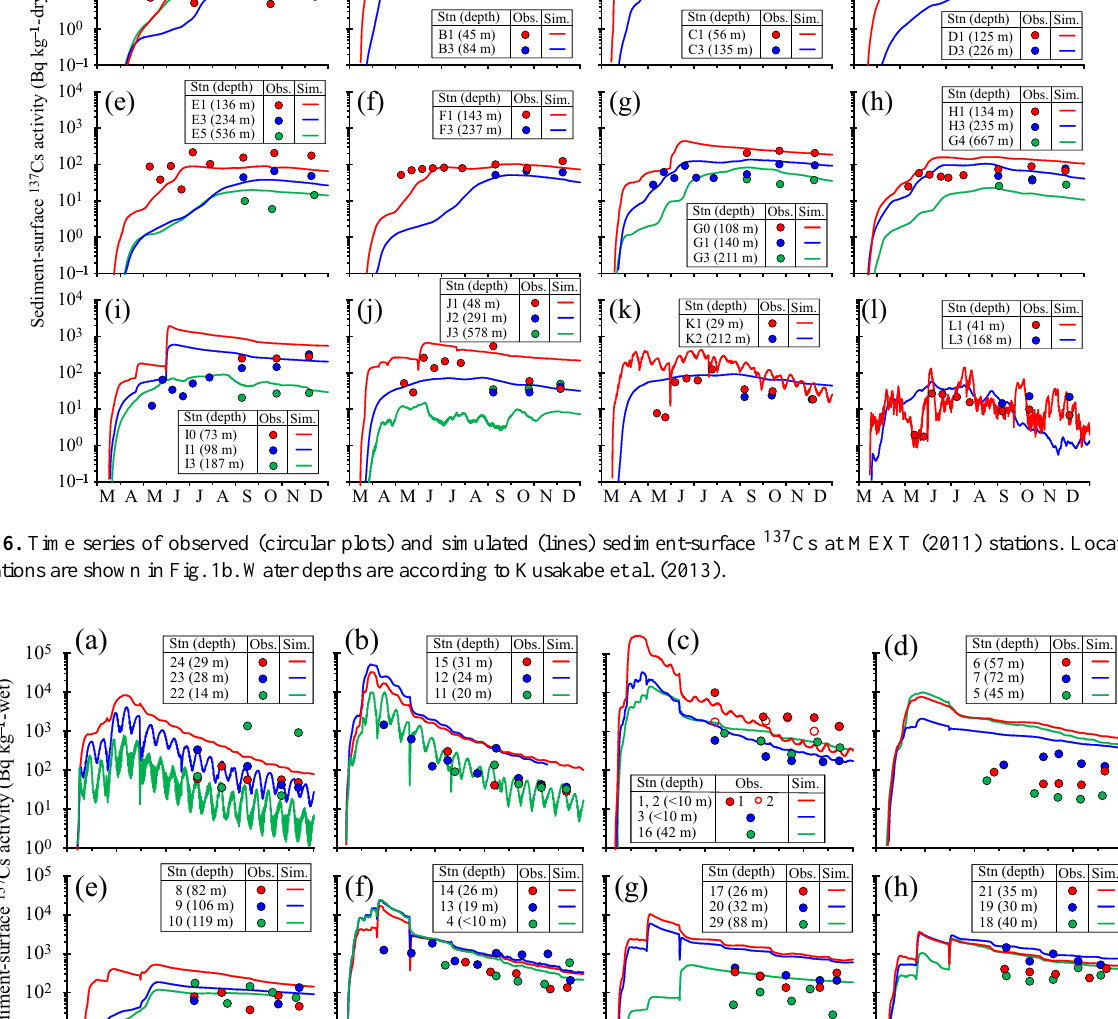
used the ideal sediment assumption over the entire simulation domain. That is, spatial distributions of sediment adsorptiv- ity with caesium input data were not input to the model, in contrast to the simulation of Misumi et al. (2014). Sequential processes causing the hotspot swath simulated by our model are discussed in detail in Sect.